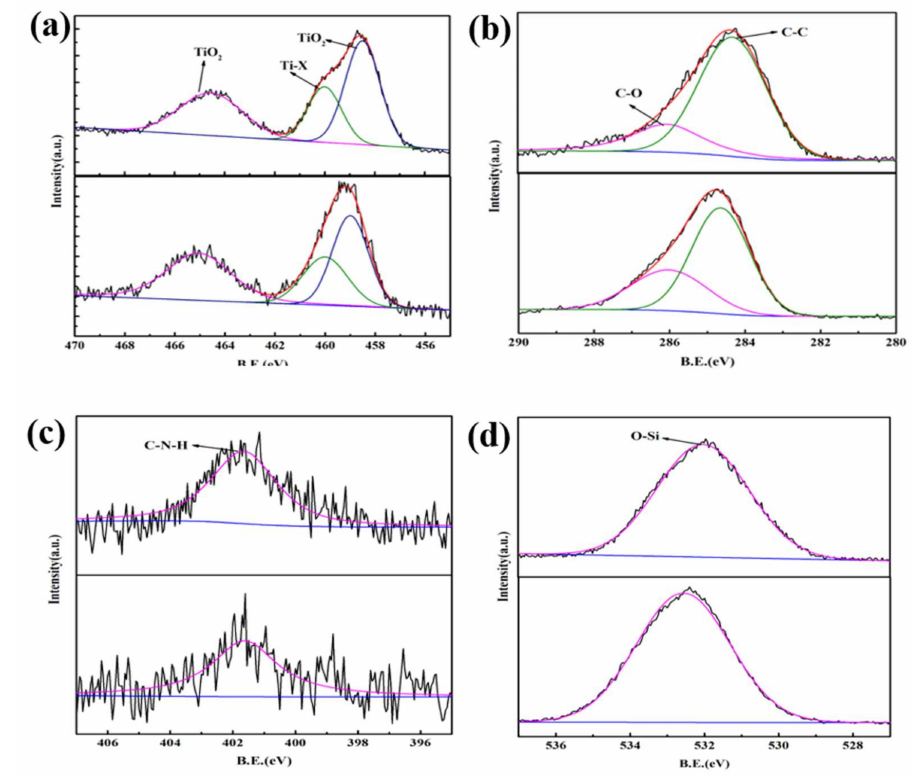
Figure 11. High resolution XPS spectra of Ti 2p ( a ), C 1s ( b ), N 1s ( c ), O 1s ( d ) in Ti-Mt-APTES before and after demulsification.